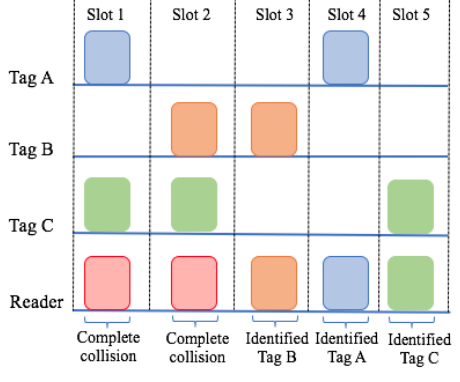
Figure 9. An example of SA.